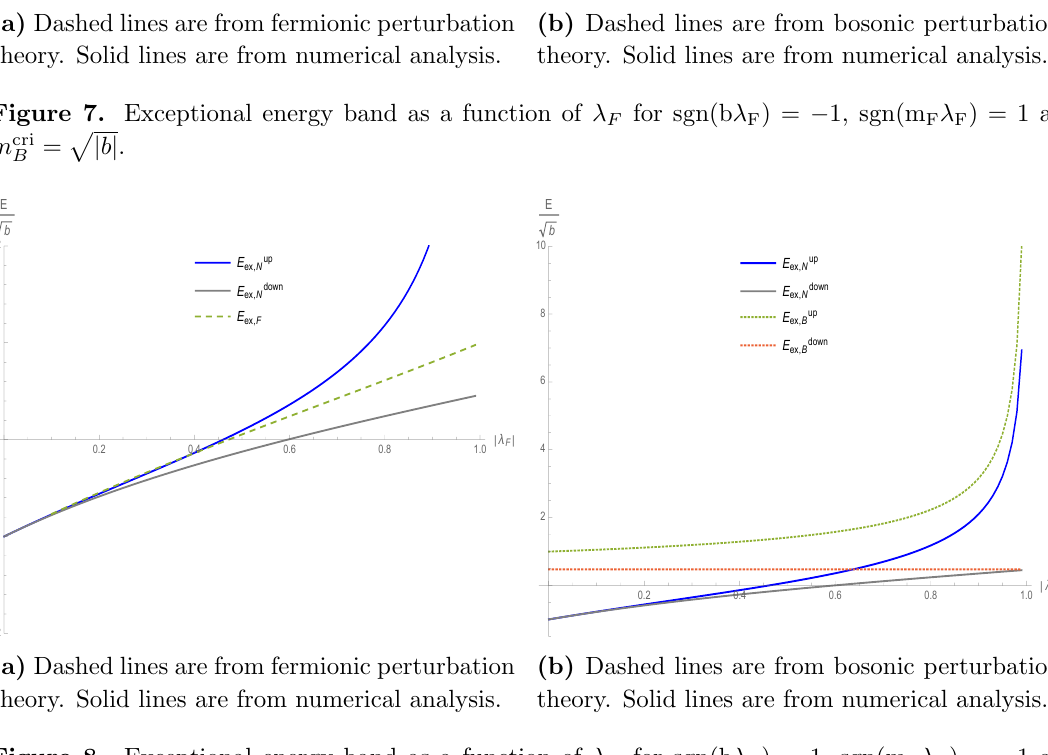
(b) Dashed lines are from bosonic perturbation theory. Solid lines are from numerical analysis.